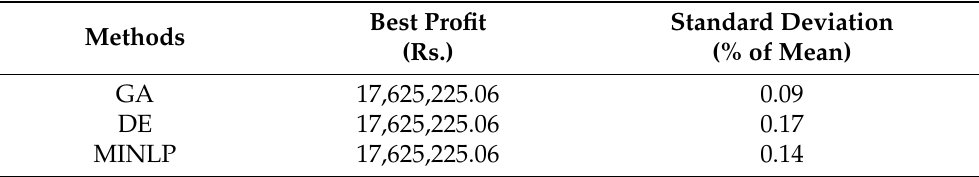
Table 9. Comparison of results with different